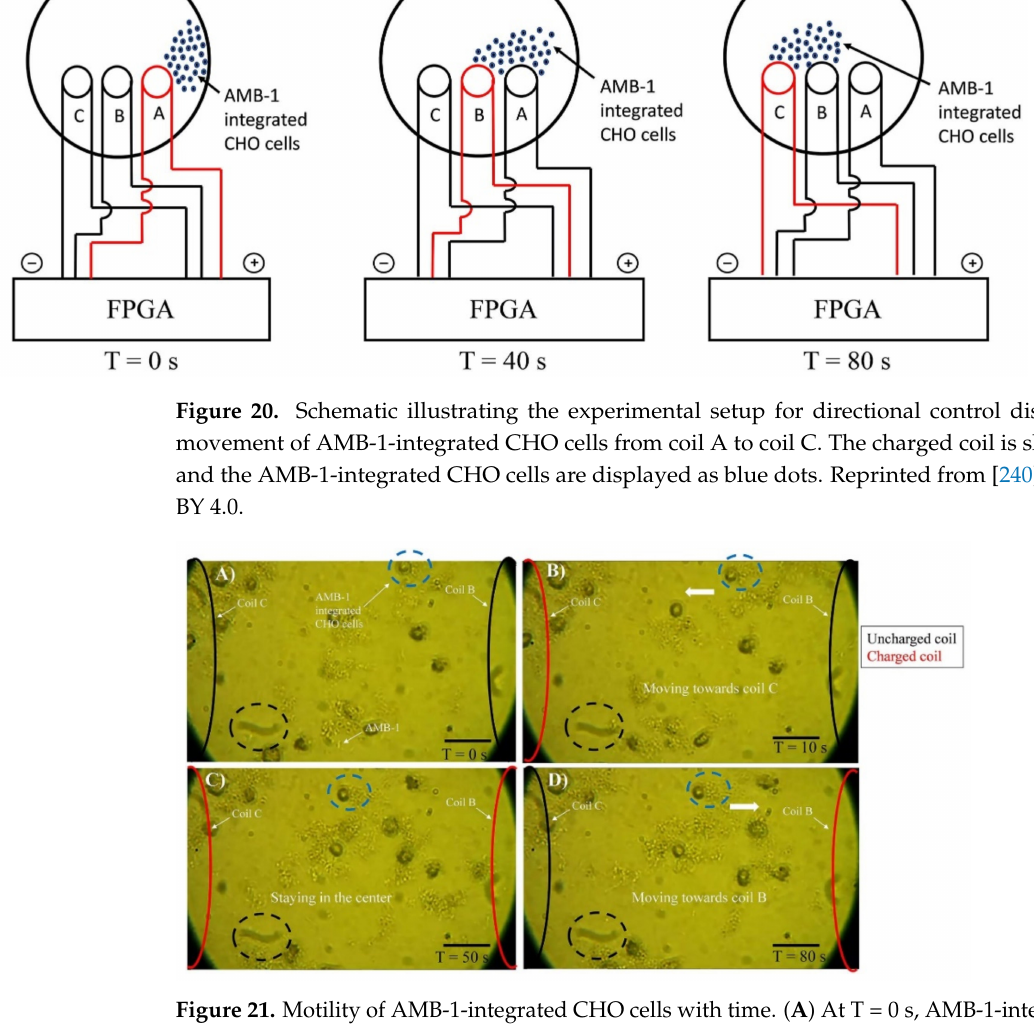
Figure 21. Motility of AMB-1-integrated CHO cells with time. ( A ) At T = 0 s, AMB-1-integrated CHO cells are moving randomly. ( B ) At T = 10 s, coil C on the left is charged and an AMB-1-integrated CHO cell, highlighted by a blue dotted circle, starts to navigate toward the charged coil C. ( C ) At T = 50 s, coils B (right) and C (left) are charged and the AMB-1-integrated CHO cell in the blue dotted circle stays in the center. ( D ) At T = 80 s, only coil C (left) is discharged and the AMB-1-integrated CHO cells can be seen moving toward coil B to the right. A stationary black dotted circle is added at the bottom of every frame to serve as a reference point. The reversal was achieved in the same manner (scale bar = 50 µ m). Reprinted from [240], license CC BY